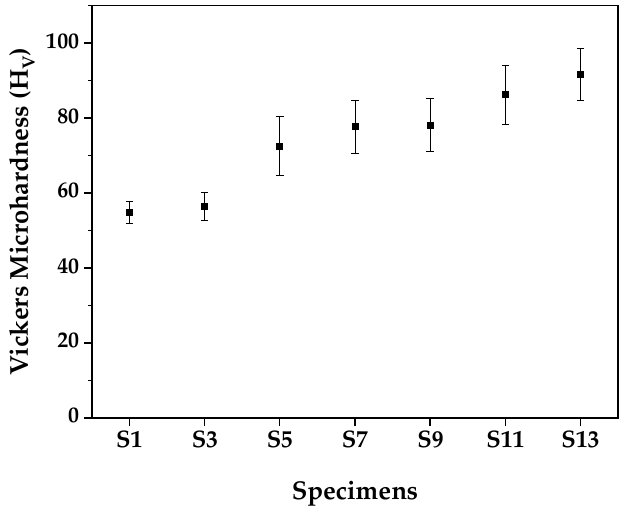
Figure 2. The effect of Si content on the micro-hardness of the Al–Si alloys.